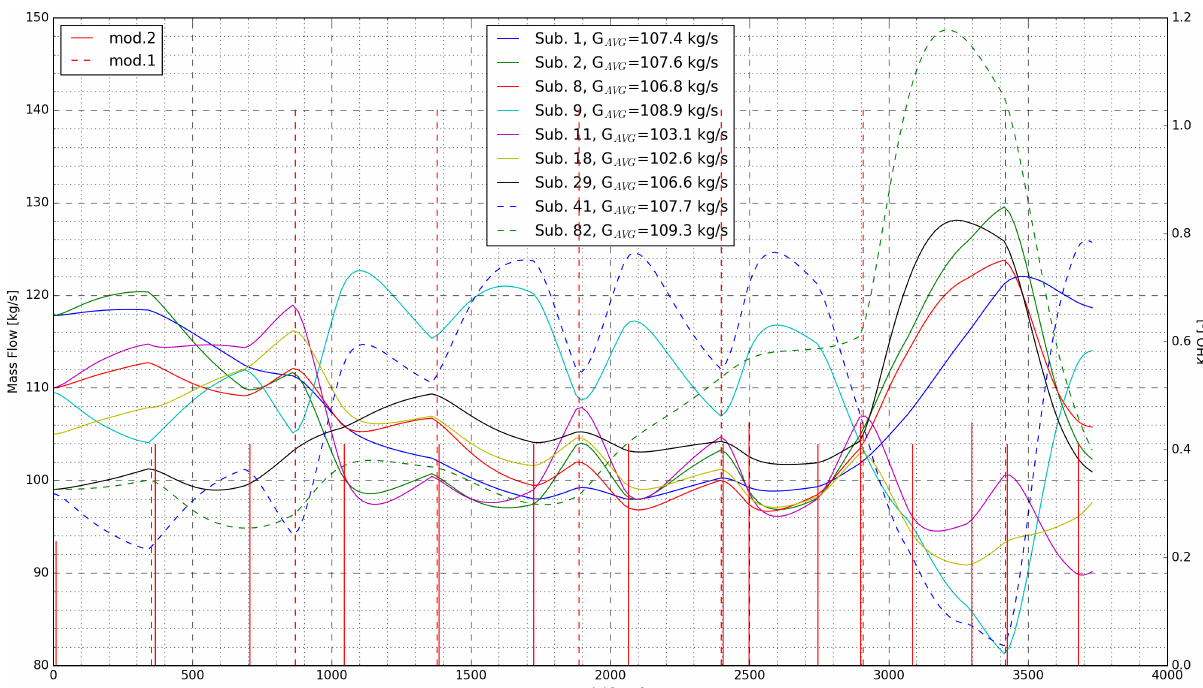
Figure 6. Mass Flow in u2c16 - 48 TVSA-T